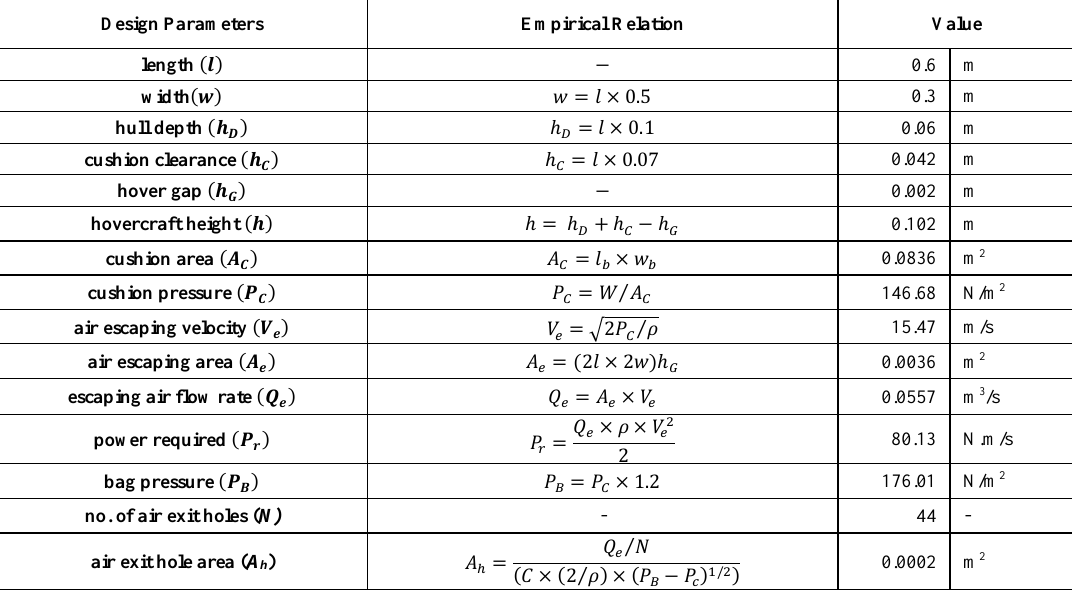
Table 1. Design summary of